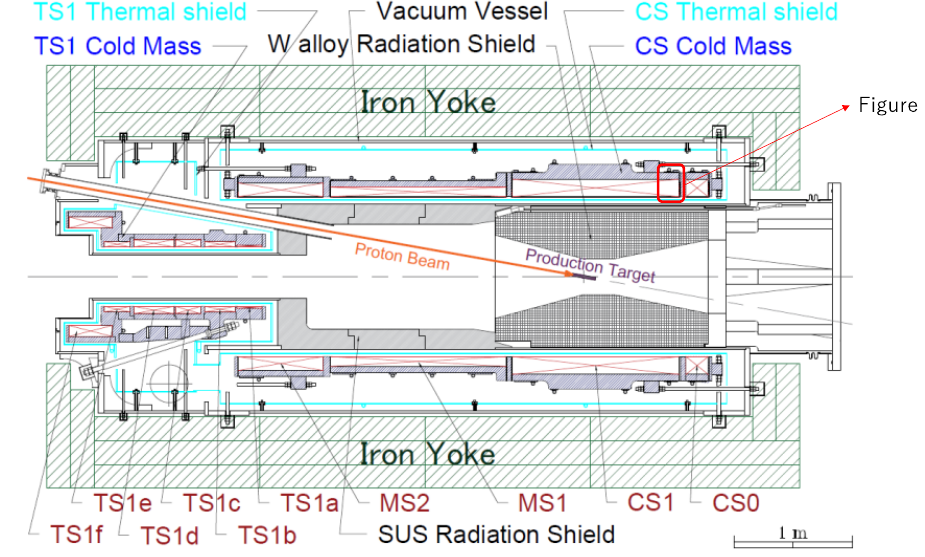
Figure 1. Design of the proposed COMET production solenoid.